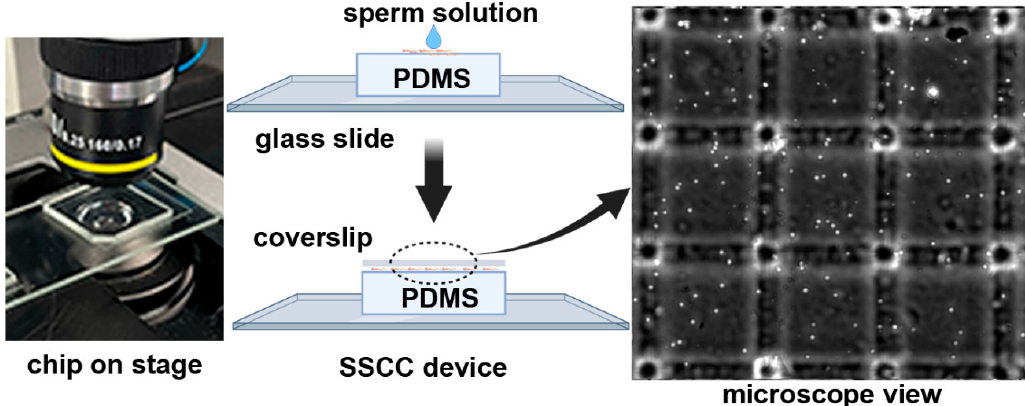
Figure 2. Operation of the SSCC device. The PDMS chip was placed on a microscope stage ( left ), sperm suspension was pipetted onto the surface, and a coverslip was applied to form a monolayer ( middle ). The 3 × 3 arrangement of chambers is shown at 100- × magnification ( right ). Created with BioRender.com.